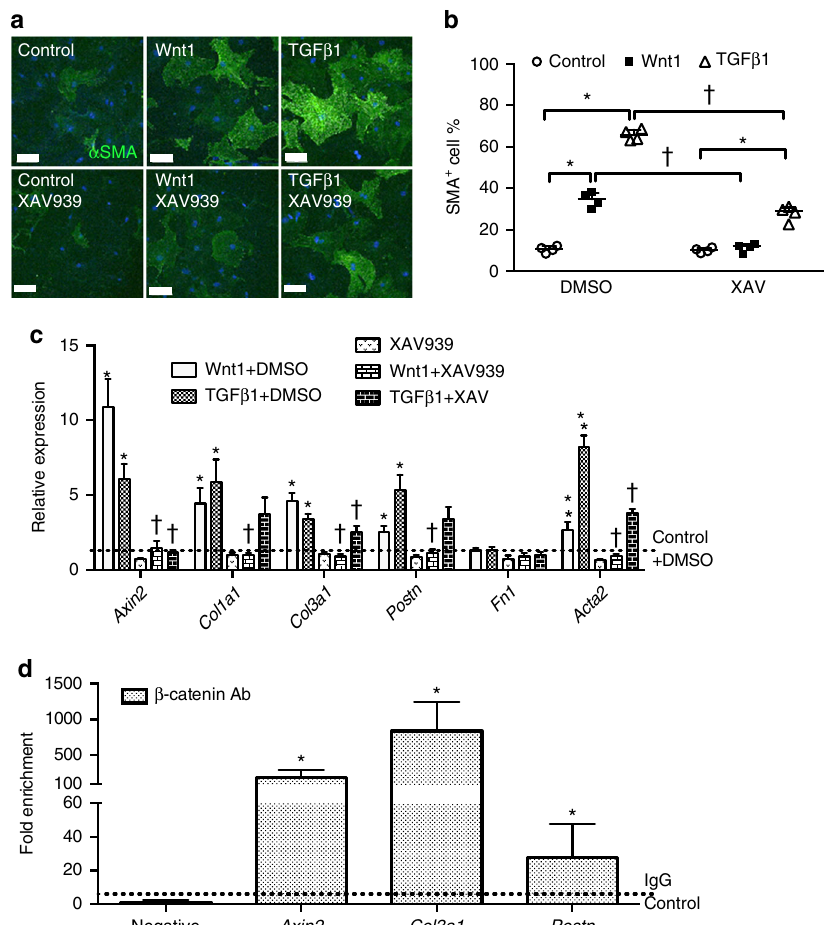
Fig. 7 Wnt/ β -catenin signaling induces cultured CF activation and ECM gene expression downstream of Tgf β signaling in vitro. a Representative images of α SMA ( green ) staining in cultured P60 CFs under indicated conditions are shown. Scale bar = 100 μ m. b Wnt1 (100 ng/ml) and TGF β 1 (10ng/ml)